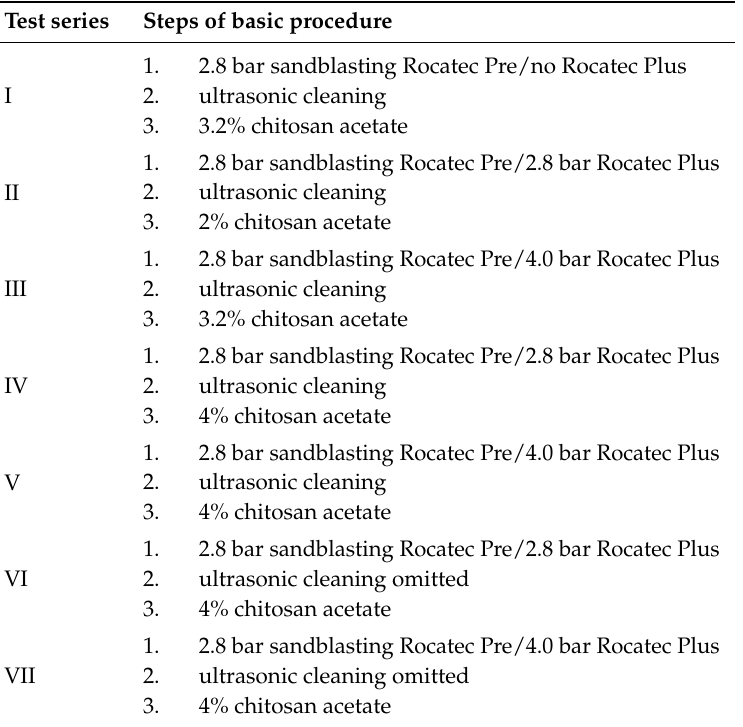
Table 1. Variations of steps 1 to 3 of the basic procedure to coat PMMA ( n = 10 each) and PET ( n = 10 each) with chitosan. Steps 4 to 6 of the basic procedure were not changed.